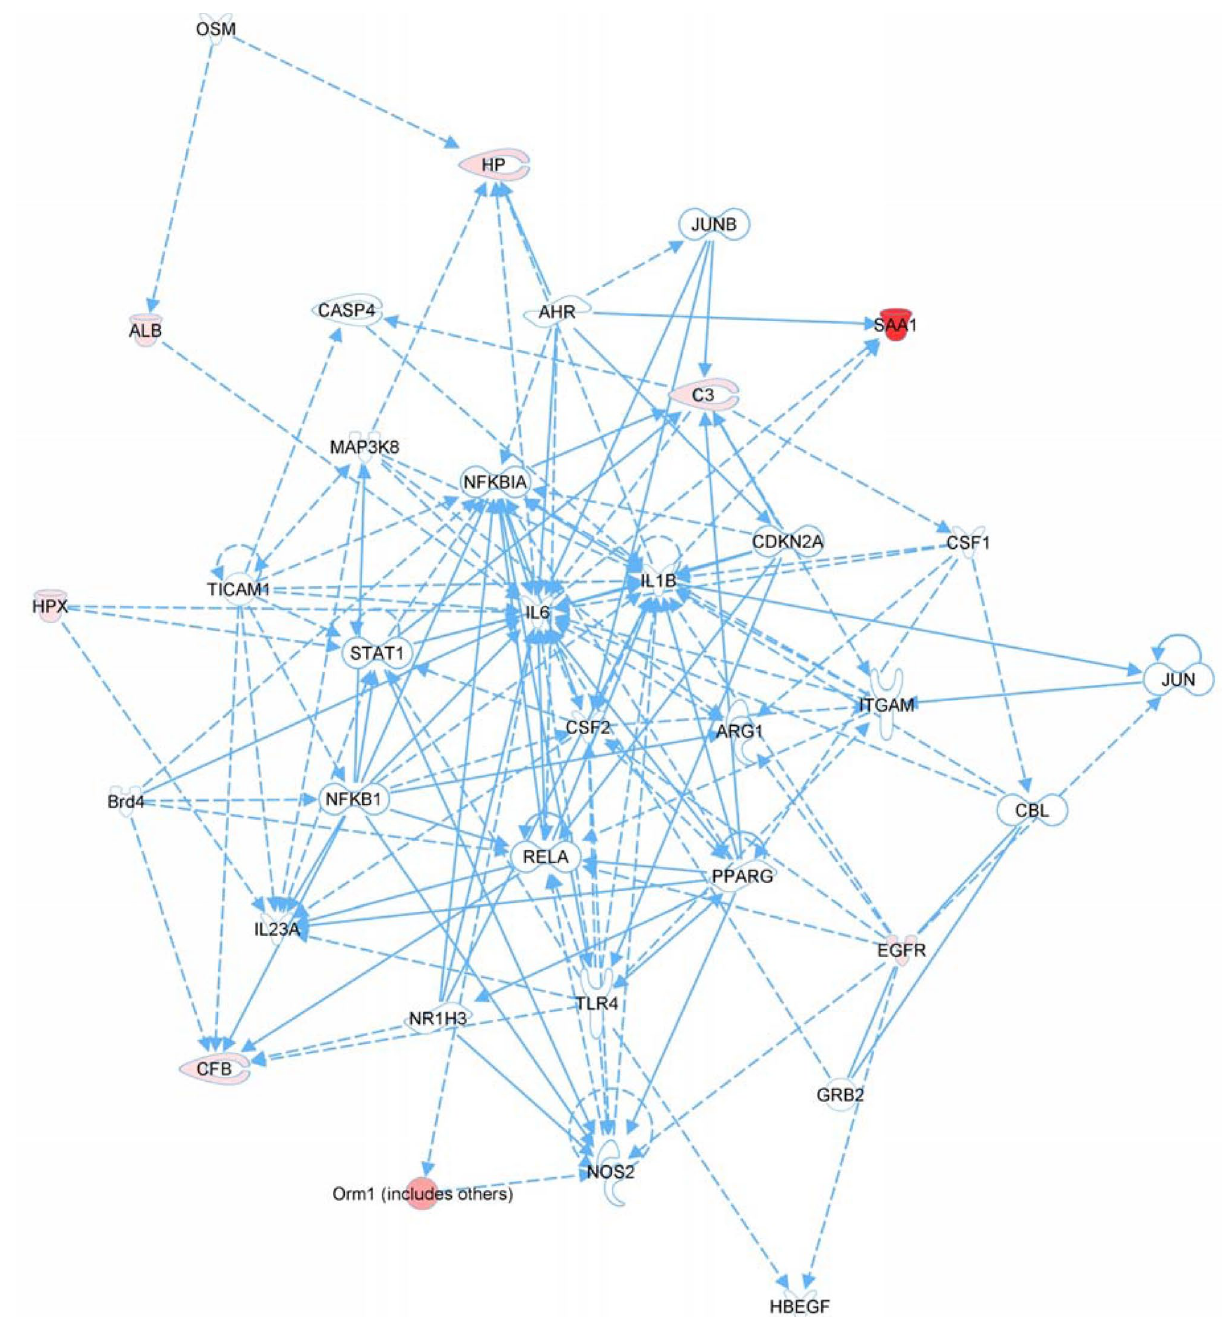
Figure 5. Network revealing relationships of serum proteins showing change in expression in response to TBI and reversal with prophylactic treatment of GT3. Ingenuity Pathway Analysis revealed proteins associated with cellular movement, immune cell trafficking, and inflammatory response. Proteins with red-fill backgrounds signify that these were down-regulated in response to TBI relative to no TBI. Proteins with no color-fill background were not identified in the MS analysis, but have a known relationship to proteins in the